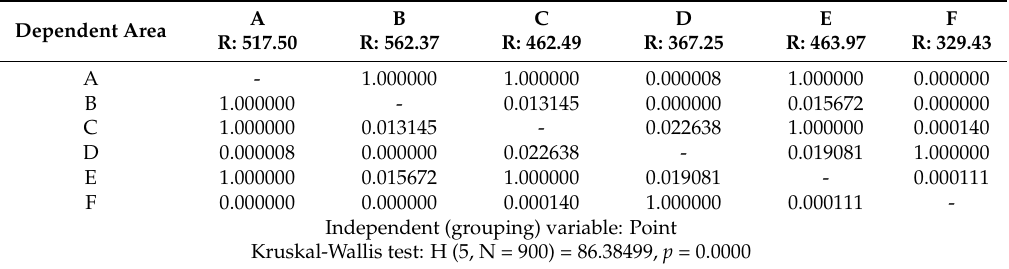
Table 7. Multiple comparisons p -values (2-tailed) of area values for point variable.